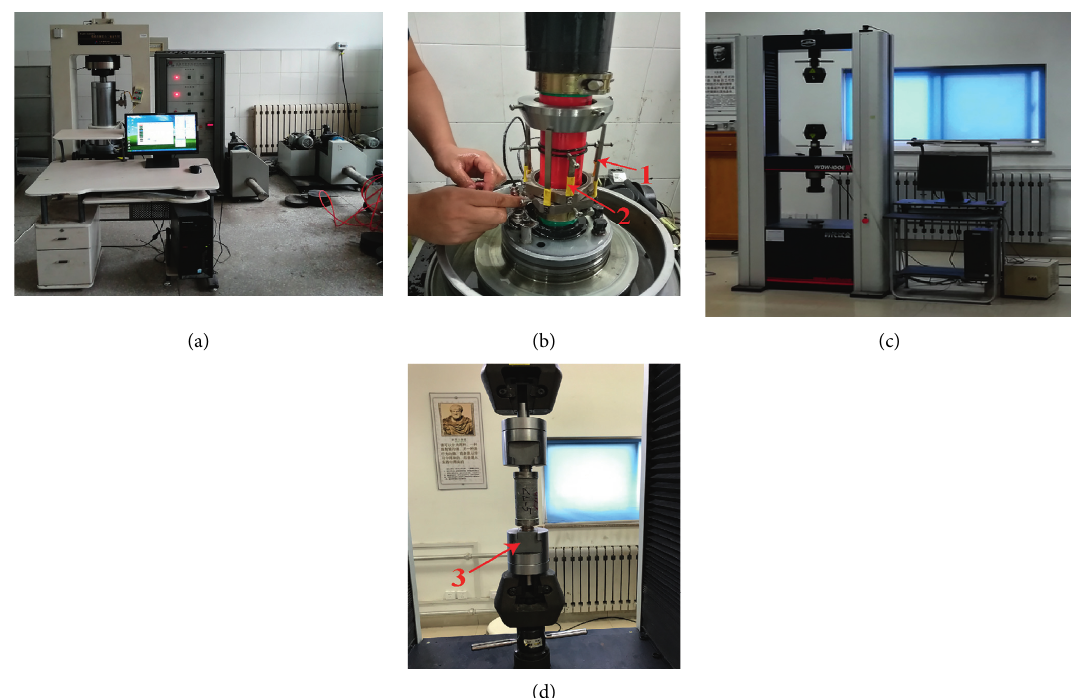
Figure 3: Testing apparatus. (a) RLW-2000 rigid servo rock mechanical test machine. (b) Specimen for conventional triaxial compression. (c) Microcomputer-controlled electronic universal test machine. (d) Specimen for direct tensile test. 1- axial strain sensor. 2- radial strain sensor. 3- fixture used for direct tensile test .